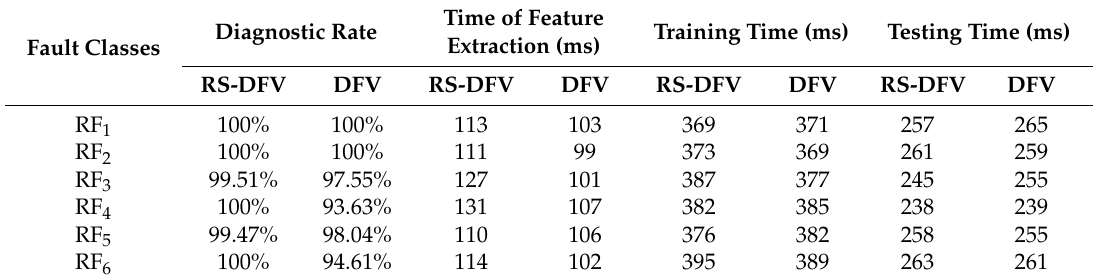
Table 10. The experimental results of RS-DFV and DFV.